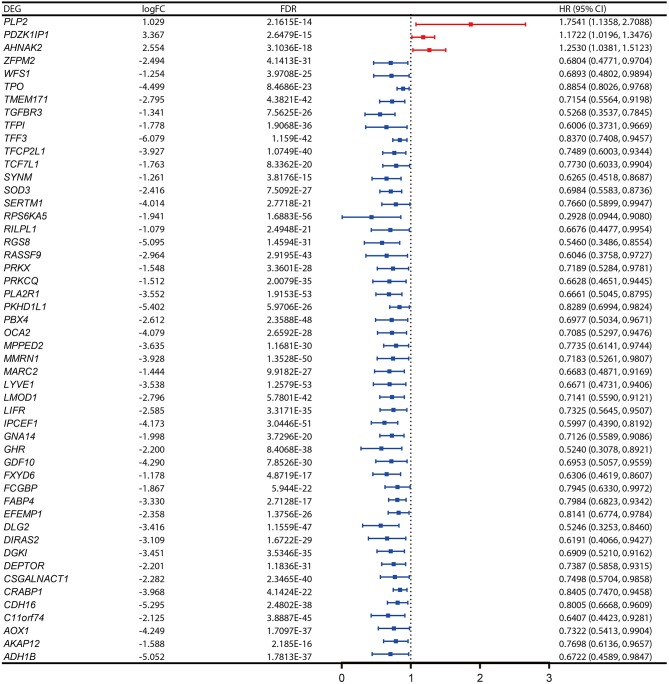
Expression profiles and the forest plot of hazard ratio (HR) showing the prognostic values of the 50 differentially-expressed genes (DEGs) associated with progression-free interval of papillary thyroid carcinoma (PTC).